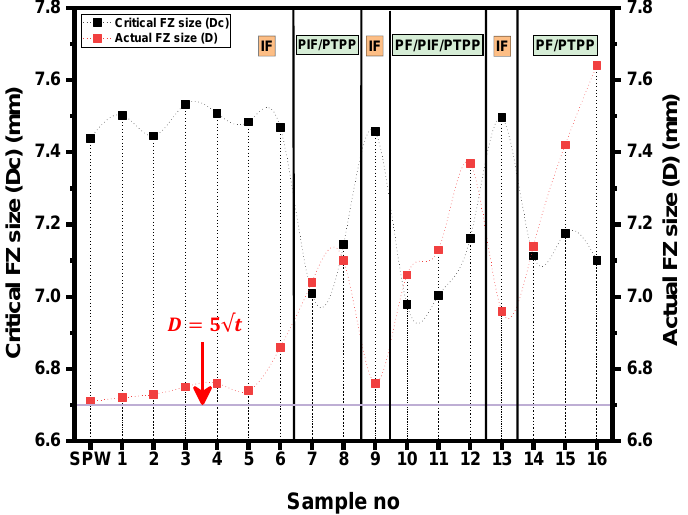
Figure 14. Relationship between critical FZ, actual FZ size and failure mode of SPW and all DPWs.